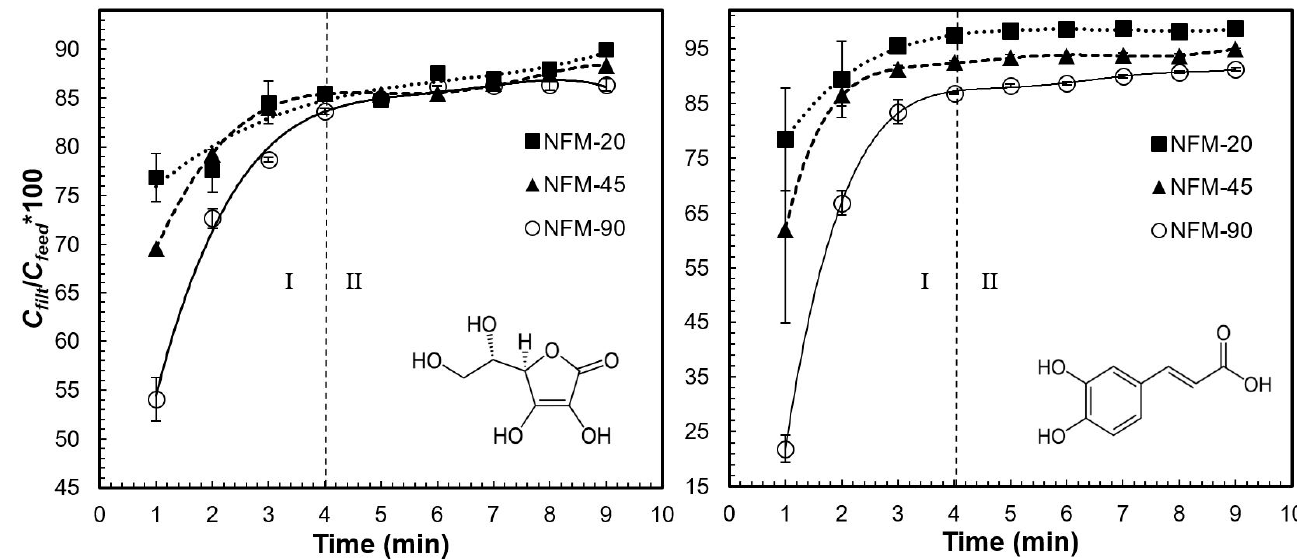
Figure 1. Change in concentration of standard solutions of typical small molecule antioxidant compounds: ( left ) ascorbic acid and ( right ) caffeic acid, during filtration with nylon-6 nanofibrous membranes of different thicknesses. Vertical error bars correspond to standard deviations of n = 3 repetitions.